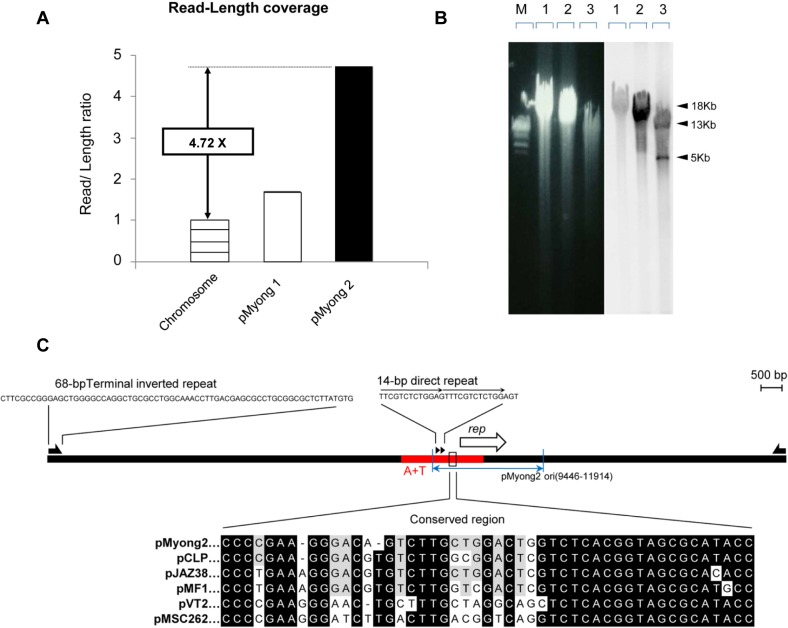
Molecular characterization of the plasmid from M. yongonense DSM 45126T.(A) The read-length coverage of pMyong2 was compared with the chromosome and circular pMyong1 plasmid DNA. (B) Southern blot analysis was used to assess the presence and validity of the linear plasmid, pMyong2. The left panel shows the results of gel electrophoresis, and the right panel shows the results of Southern blot analysis. The 1-kb DNA ladder (M), M. intracellulare genomic DNA (lane 1), M. yongonense genomic DNA (lane 2), and XhoI-digested M. yongonense genomic DNA (lane 3) are shown. (C) Comparison of the replication origin sequence in pMyong2 with those of other mycobacteria plasmids. The rep gene is indicated with an open arrow. The arrowheads indicate the 18-bp repeat sequences. The AT-rich segment of the replication origin region is indicated as ‘A+T’ in red. A comparison of the conserved sequences in pMyong2 with those of other mycobacterial plasmids, including pCLP (GenBank Accession No., AF312688), pJAZ38 (GenBank Accession No., MFU85216), pMF1 (GenBank Accession No., AJ238973), pVT2 (GenBank Accession No., AY0565023), and pMSC262 (GenBank Accession No., D14416), is shown. Nucleotides identical to the pMyong2 sequence are indicated with black backgrounds.